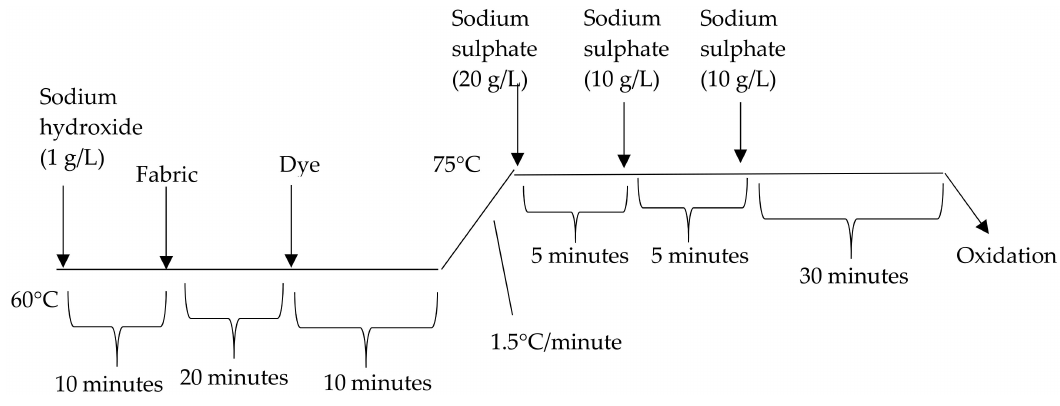
Figure 1. Dyeing profile of sulphur dye.